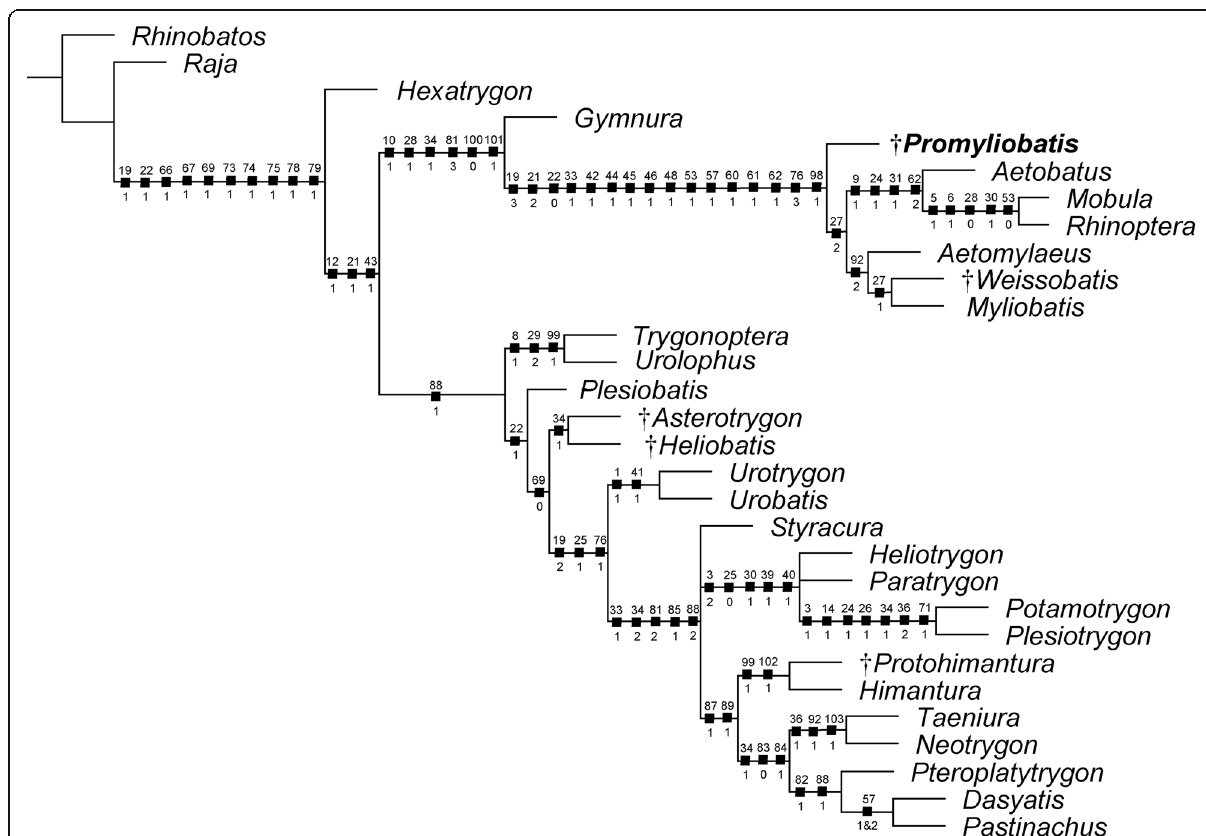
Fig. 8 The single tree retrieved by the branch-and-bound method showing the hypothetical relationships of Promyliobatis gazolai within the Myliobatiformes using living and fossil taxa based on holomorphic specimens. Number character above and state below on each node. Extinct taxa are marked with a dagger preceding their